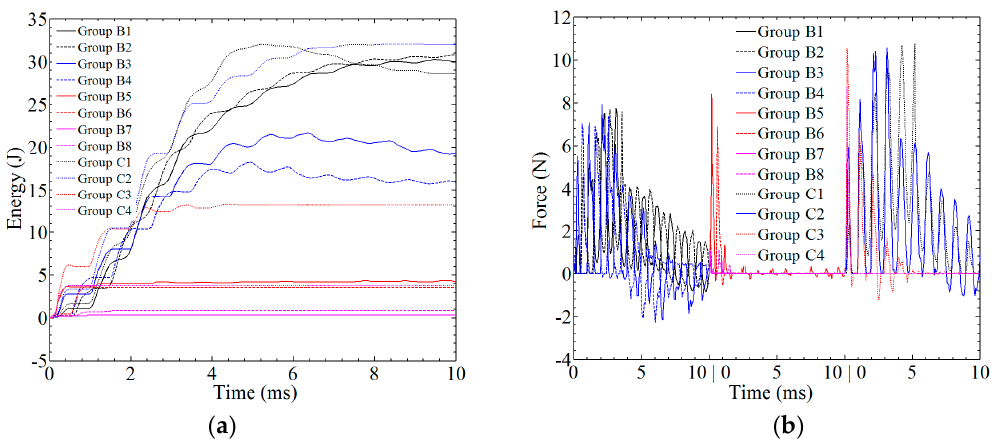
Figure 14. The analysis of the impact resistance of the composite laminate in group B and C: ( a ) absorbed energy; ( b ) contact force.